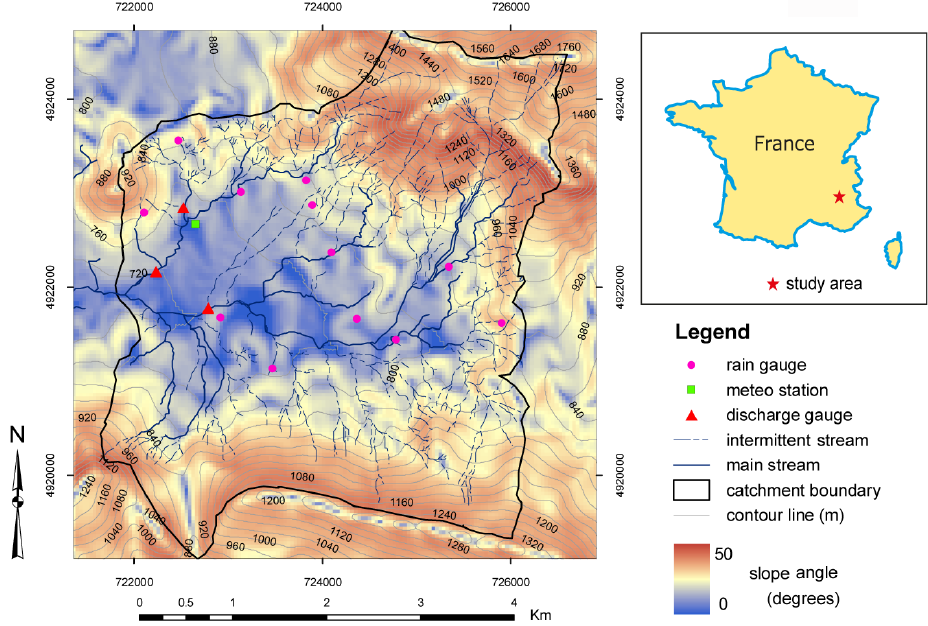
Fig. 2. Location and topographical characteristics of the study catchment, including the measurement locations of rainfall, meteo, and discharge